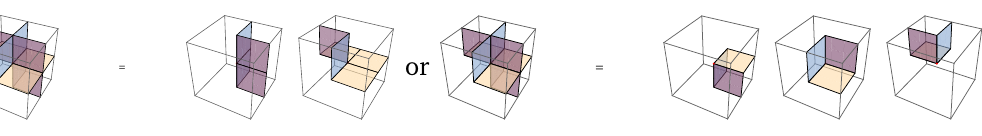
Figure 4: The contribution of a given vertex to the euler character is ambiguous. In this example, depending on the chosen resolution, it is either 2 or